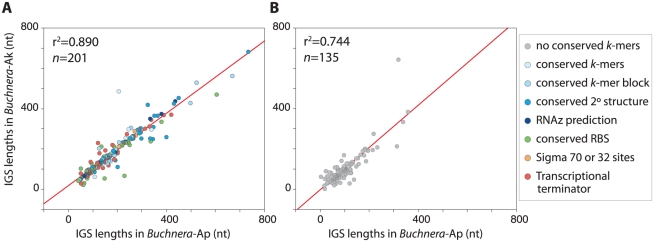
Lengths of orthologous IGSs in Buchnera-Ap and Buchnera-Ak.Intergenic spacers (IGSs) are divided into those (A) with and (B) without conserved elements and color-coded according to their inferred functions and/or presence of conserved k-mers. Conserved “k-mer blocks” are defined as ≥2 k-mers less than 30 nt apart or k-mers≥10 nt.